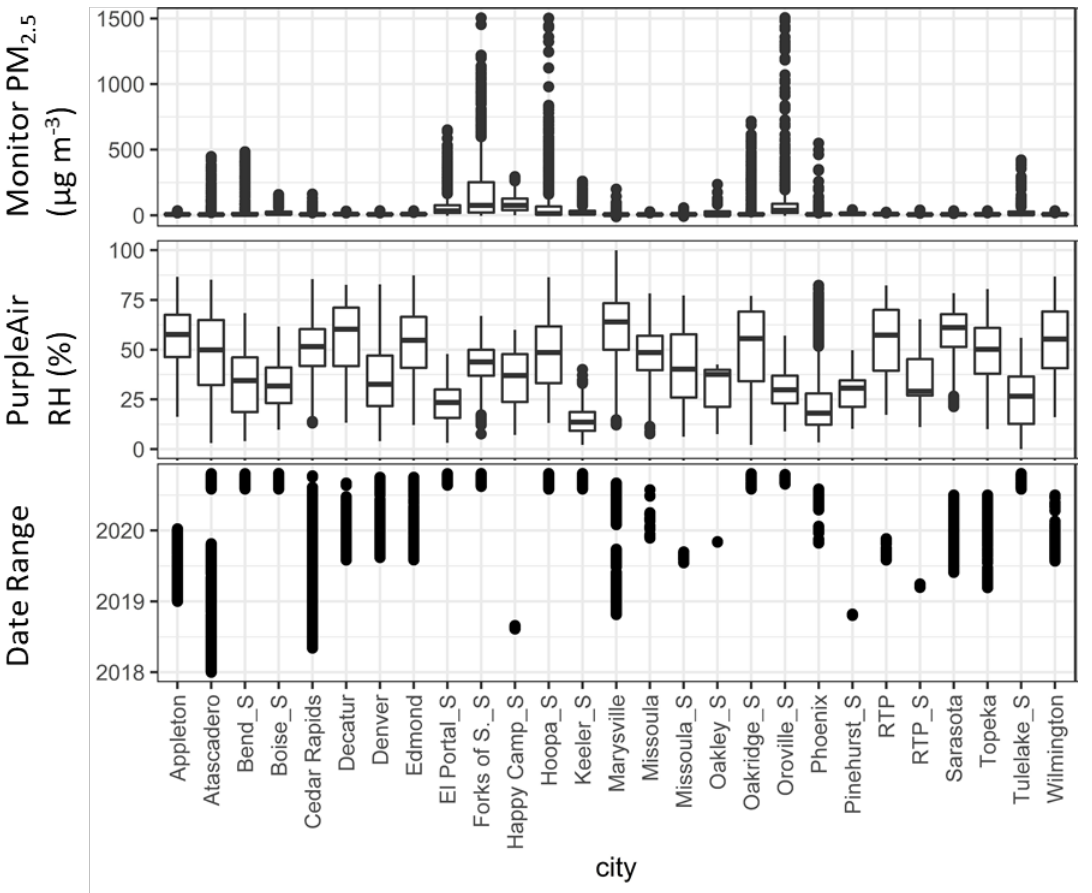
Figure 2. Summary of the distribution of RH and PM 2.5 for each sensor (withholding groups). The Atascadero sensor experienced both typical ambient and smoke − impacted periods.